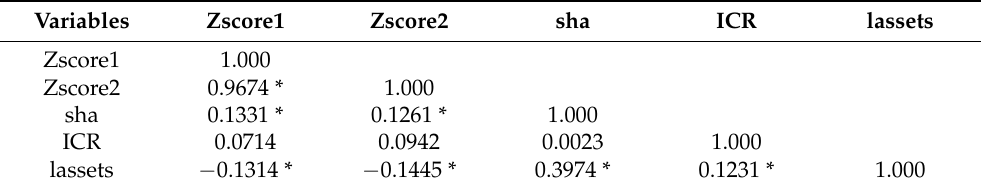
Table 3. Correlation Matrix.